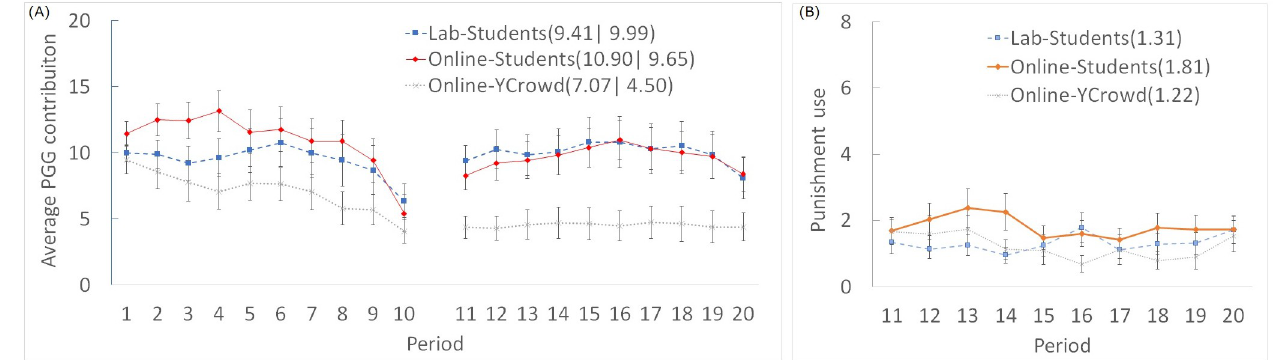
Fig 1. (A) The PGG contribution and (B) use of punishment over time. Numbers in parentheses are the mean contributions or punishment use in each experimental condition. Error bars indicate standard errors (clustered at the group level). “Online-YCrowd” indicates data of the Yahoo crowdsourcing sample collected in the additional